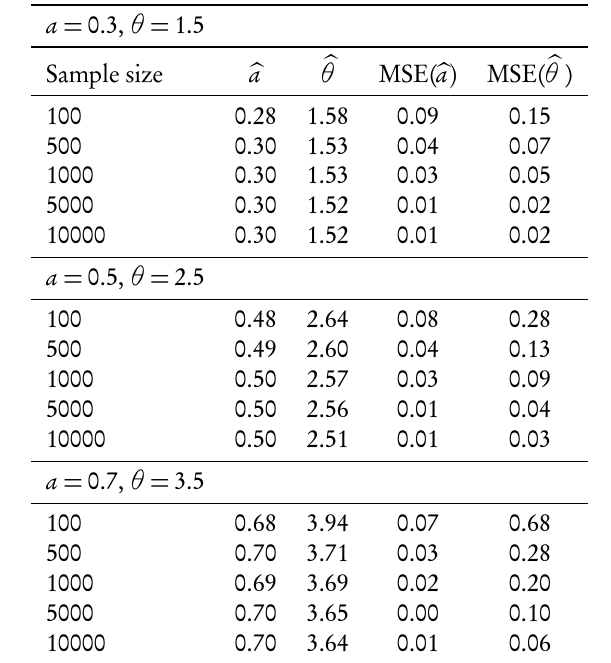
Estimated values of a, θ and corresponding mean square error